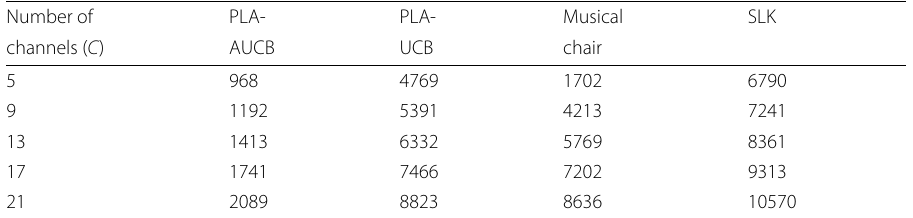
Table 3 Regret comparison in the multi-user case with n = 10 5 using the four algorithms PLA-AUCB, PLA-UCB, musical chair, and SLK with a changing number of channels